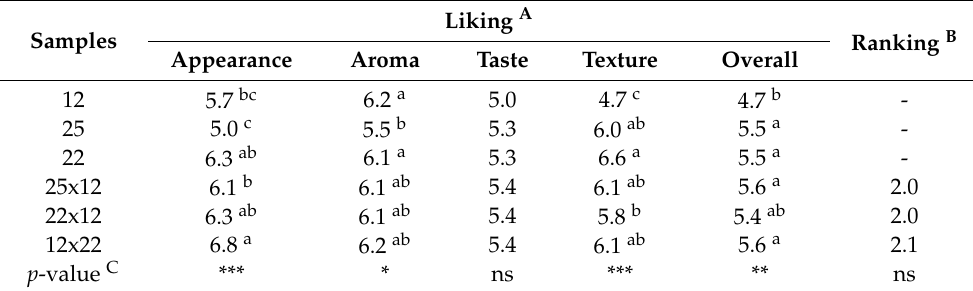
Table 4. Liking scores and preference ranking for celery samples.